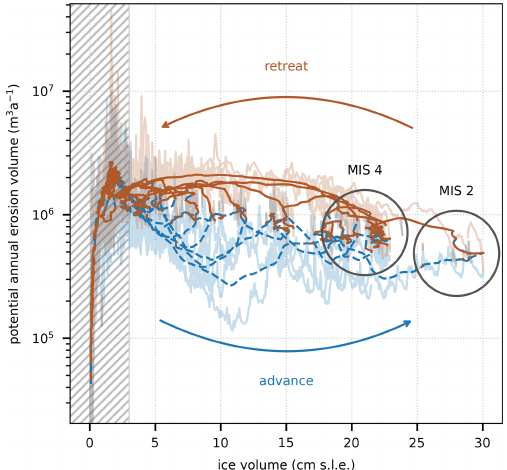
Figure 2. Modelled annual (domain-integrated) potential erosion volume (light curves) and its 1ka running mean (dark curves) in relation to the modelled total ice volume in centimetres of sea-level equivalent. Blue dashed lines indicate increasing ice volume and solid brown lines decreasing ice volume. Hatching indicates low confidence due to limited glacier